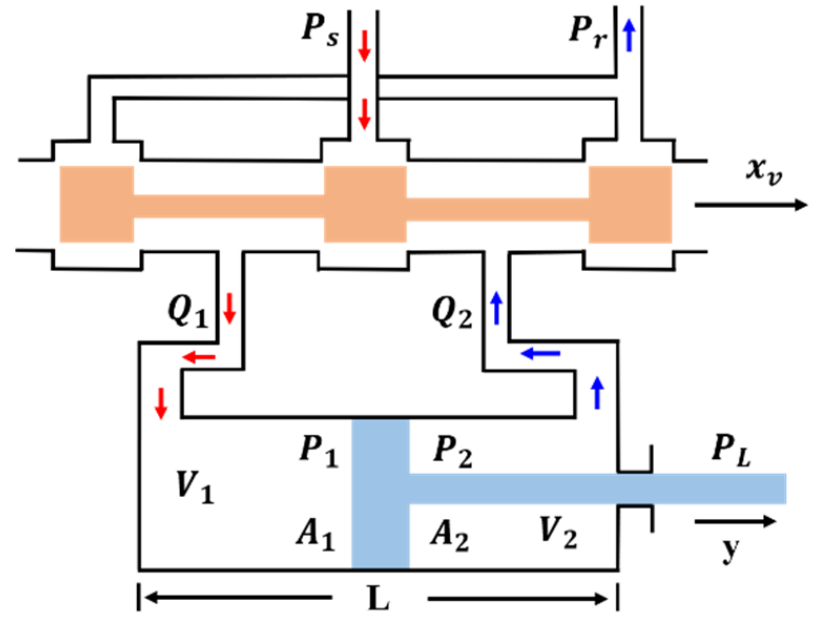
Figure 3. Schematic diagram of asymmetric hydraulic cylinder.